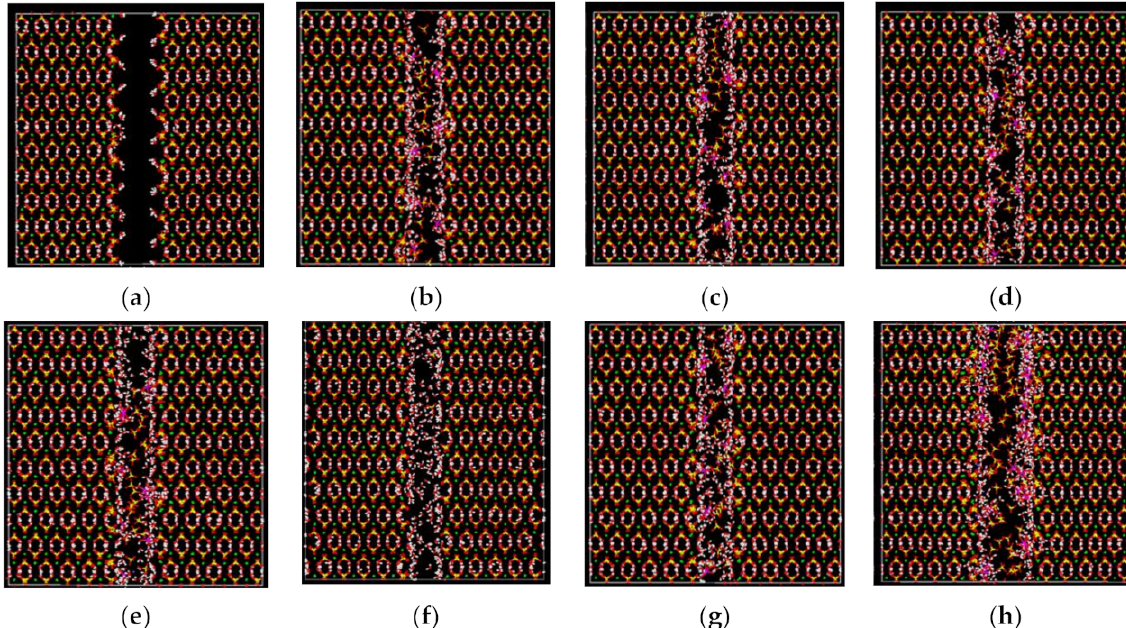
Figure 9. CaSO 4 · 2H 2 O model with hydration product adsorption: ( a ) model with G 0 contents, ( b ) model with F 1 contents, ( c ) model with F 2 contents, ( d ) model with F 3 contents, ( e ) model with F 4 contents, ( f ) model with P 1 contents, ( g ) model with P 2 contents, and ( h ) model with P 3 contents. (White balls are hydrogen, red balls are oxygen, yellow balls are sulfur, green balls are calcium, purple balls are sodium, and pink balls are